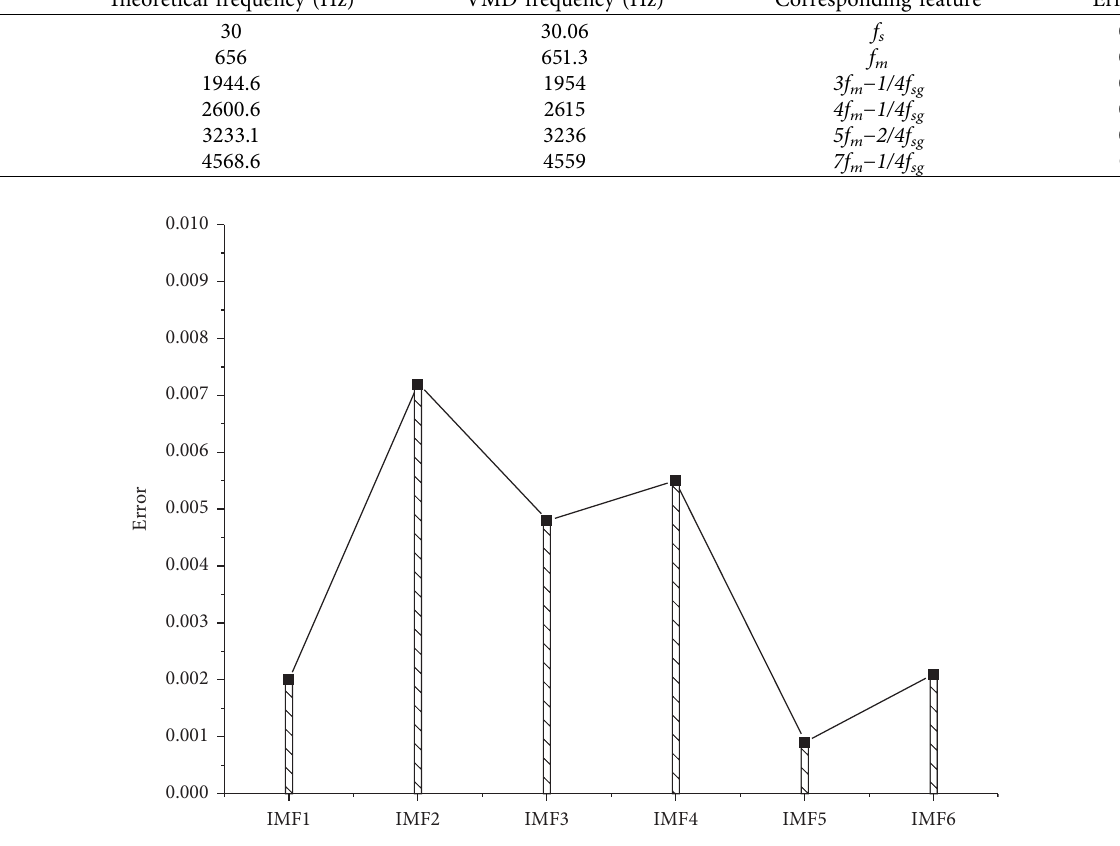
Figure 18: Error between the tested VMD IMF central frequency and theoretical value for 3 #